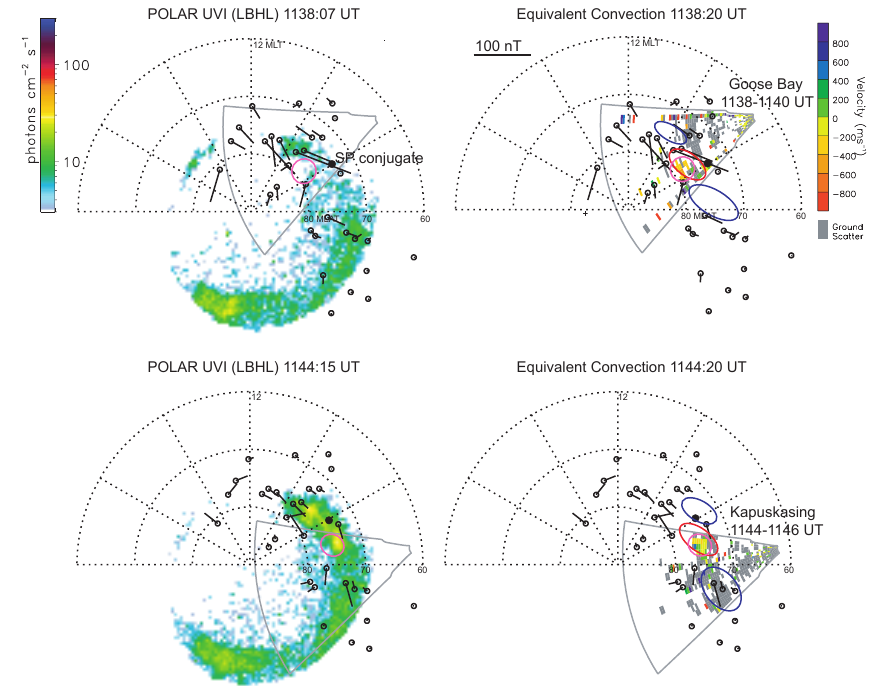
Fig. 2. Equivalent ionospheric convection velocities, POLAR-UVI auroral images, and SuperDARN Doppler velocities in the 24 July 1996 event. The format is the same as Fig.